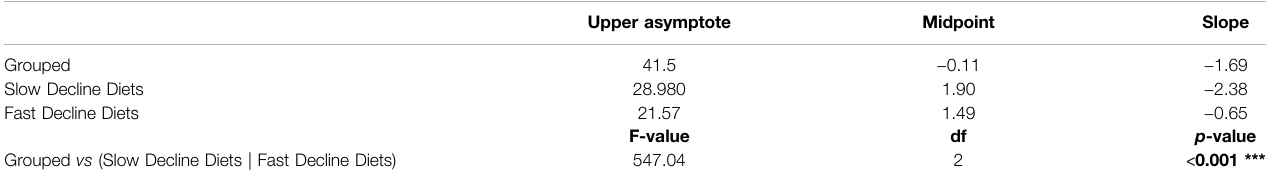
TABLE 1 | Comparison of egg laying dynamics coef fi cients between fast decline and slow decline diets. Diets were compared using a logistic model, y = asymptote1+ emidpoint − xslope, where y is the number of eggs laid per female and x is day. Upper asymptote